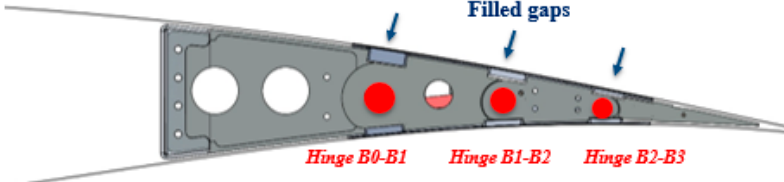
Figure 9. Compliant morphing rib concept: 2D view with detail of hinges and blocks.